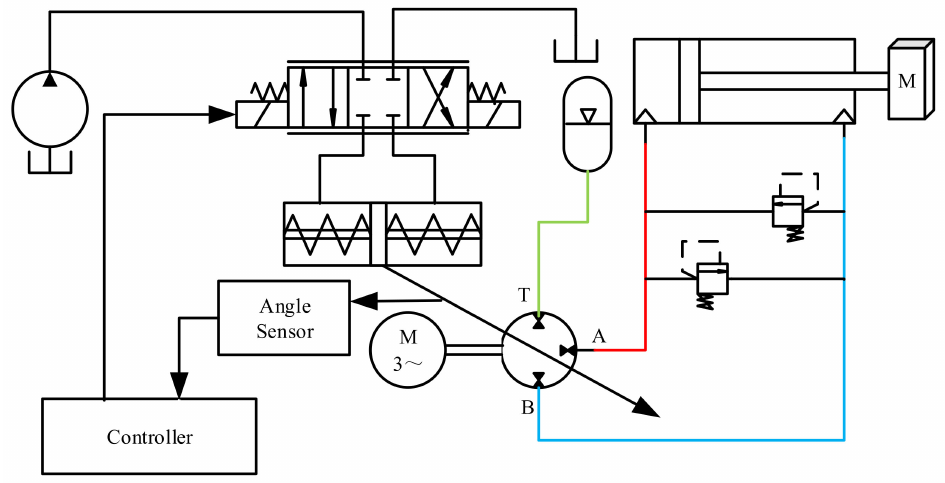
Figure 1. Schematic of differential cylinder driven by VAPP and energy